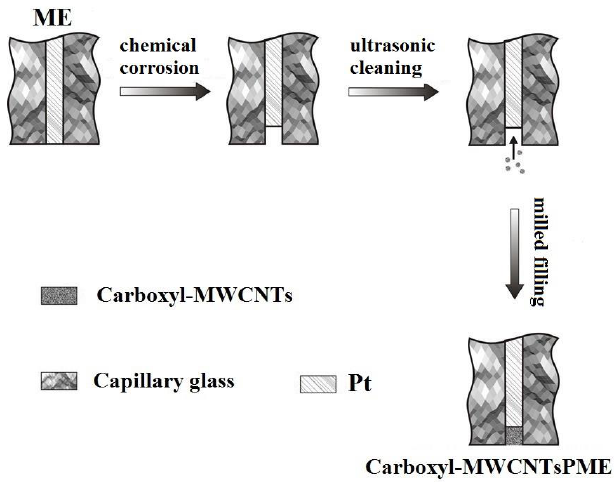
Figure 2. Fabrication of PME for AA detecting.